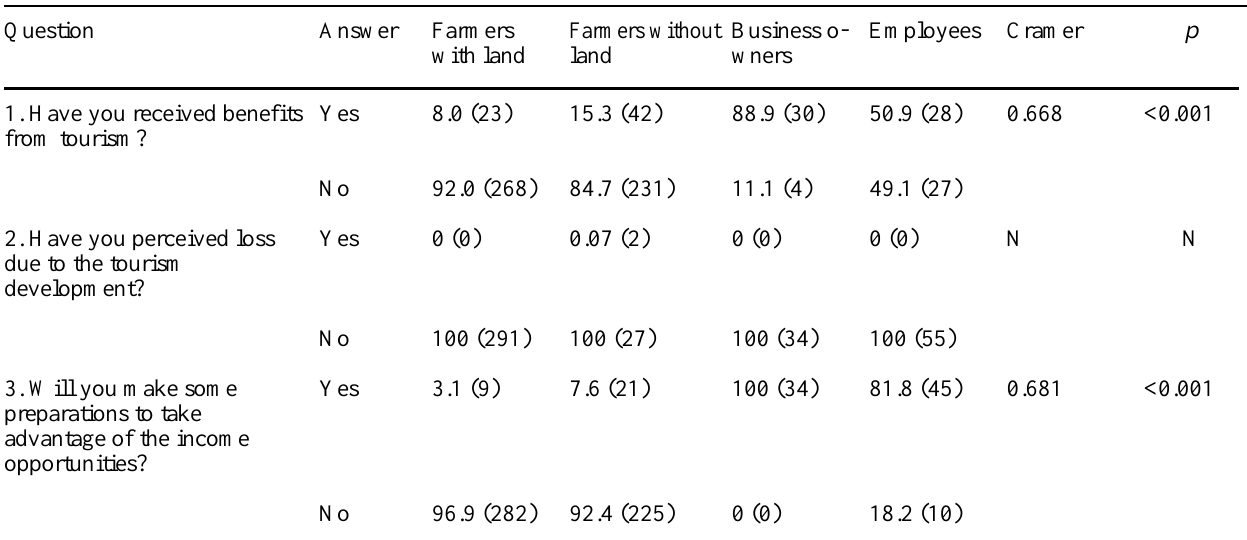
Table 4. Respondents’ perceptions regarding the ecotourism industry